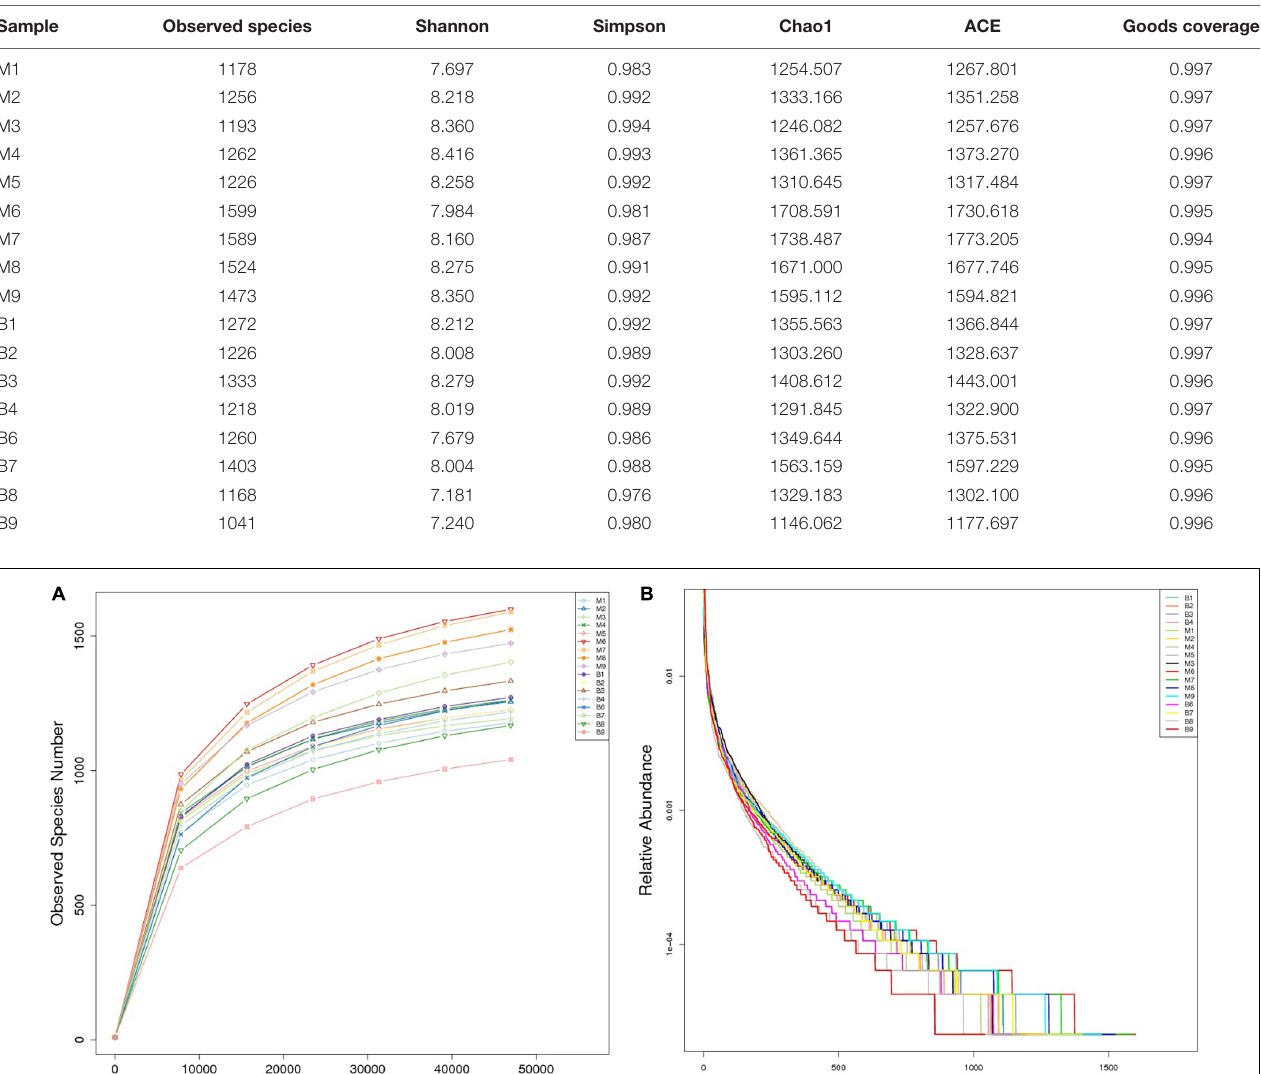
TABLE 2 | Alpha-diversity of gut microbiota in fecal samples from European mouflon and blue sheep. Sample